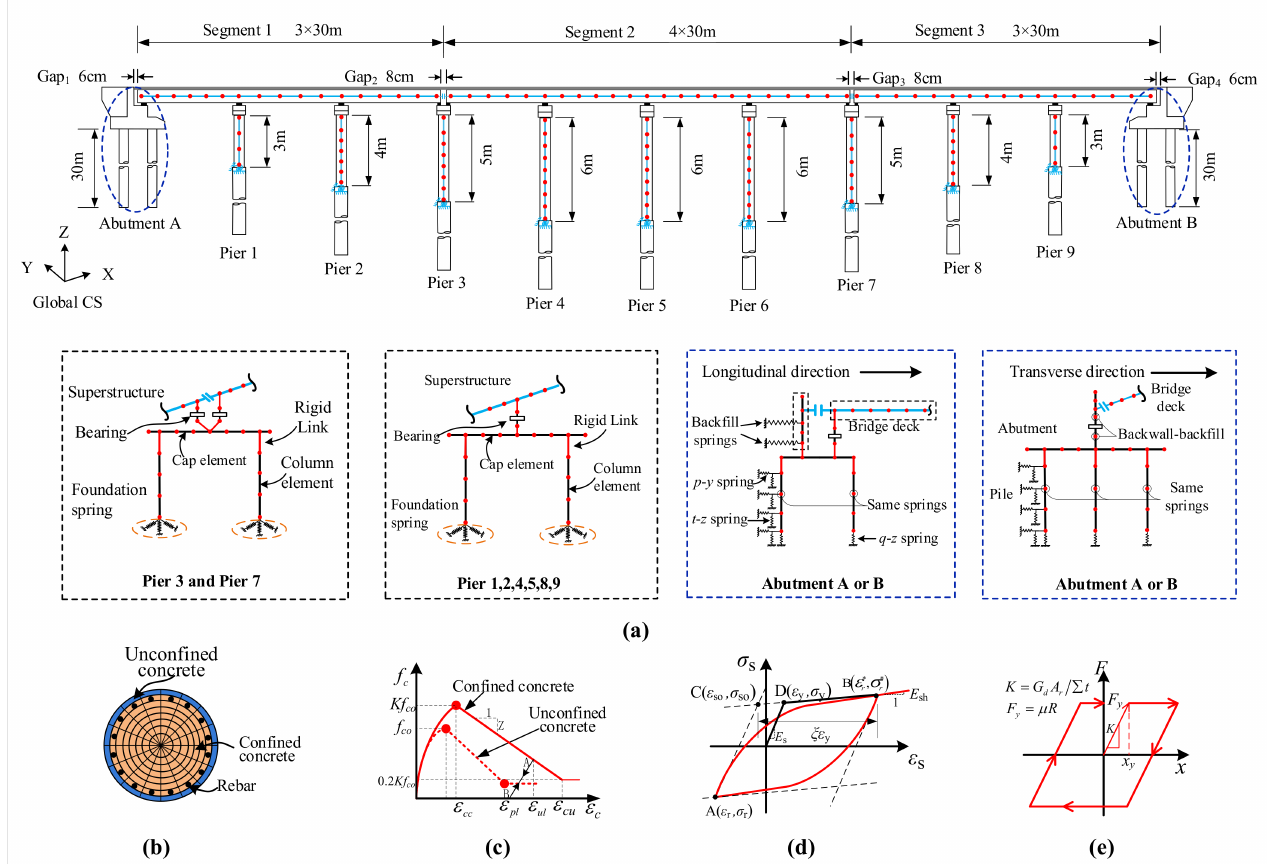
Figure 3. Numerical model and material constitution of the bridge: ( a ) numerical model; ( b ) fiber section; ( c ) concrete stress-strain constitutive model; ( d ) rebar stress-strain constitutive model; ( e ) hys- teresis model of pot-type